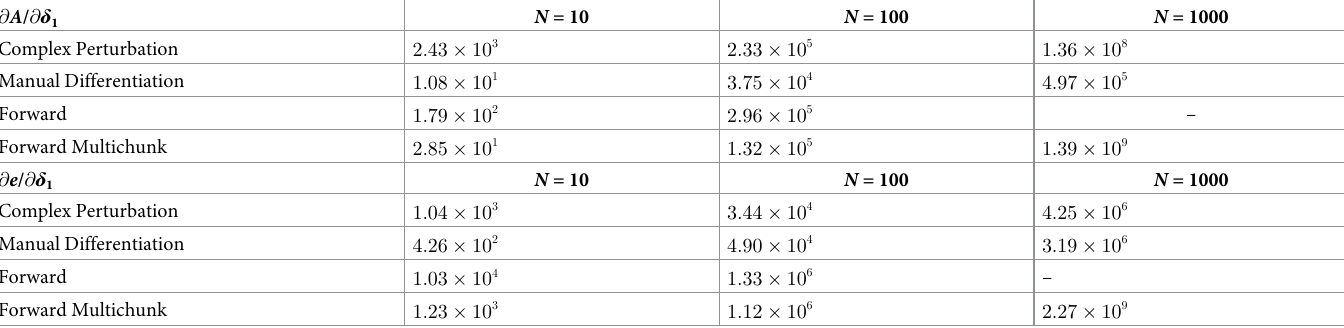
Table 7. Computational time ( μ s) for the branching process model. Model parameters are generated randomly on the range β 2 [0.05,0.16], δ 2 [0.05,0.19], and λ 2 [0.0003,0.00046]. Manual differentiation relies on differentiating Eq 11 and Eq 9 for the branching process model.